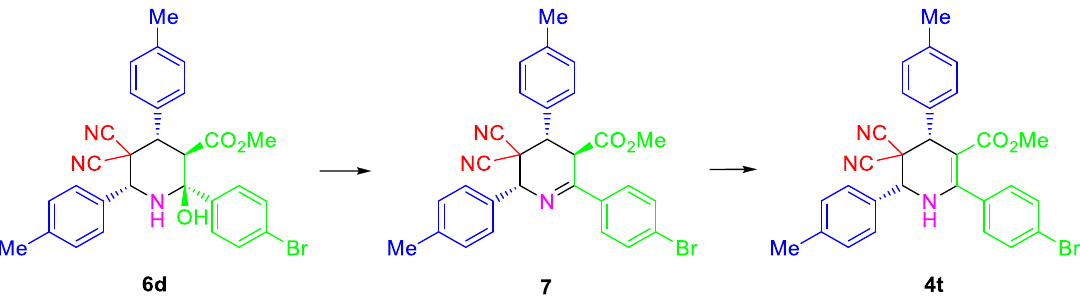
Table 3. Dehydration of 6d а